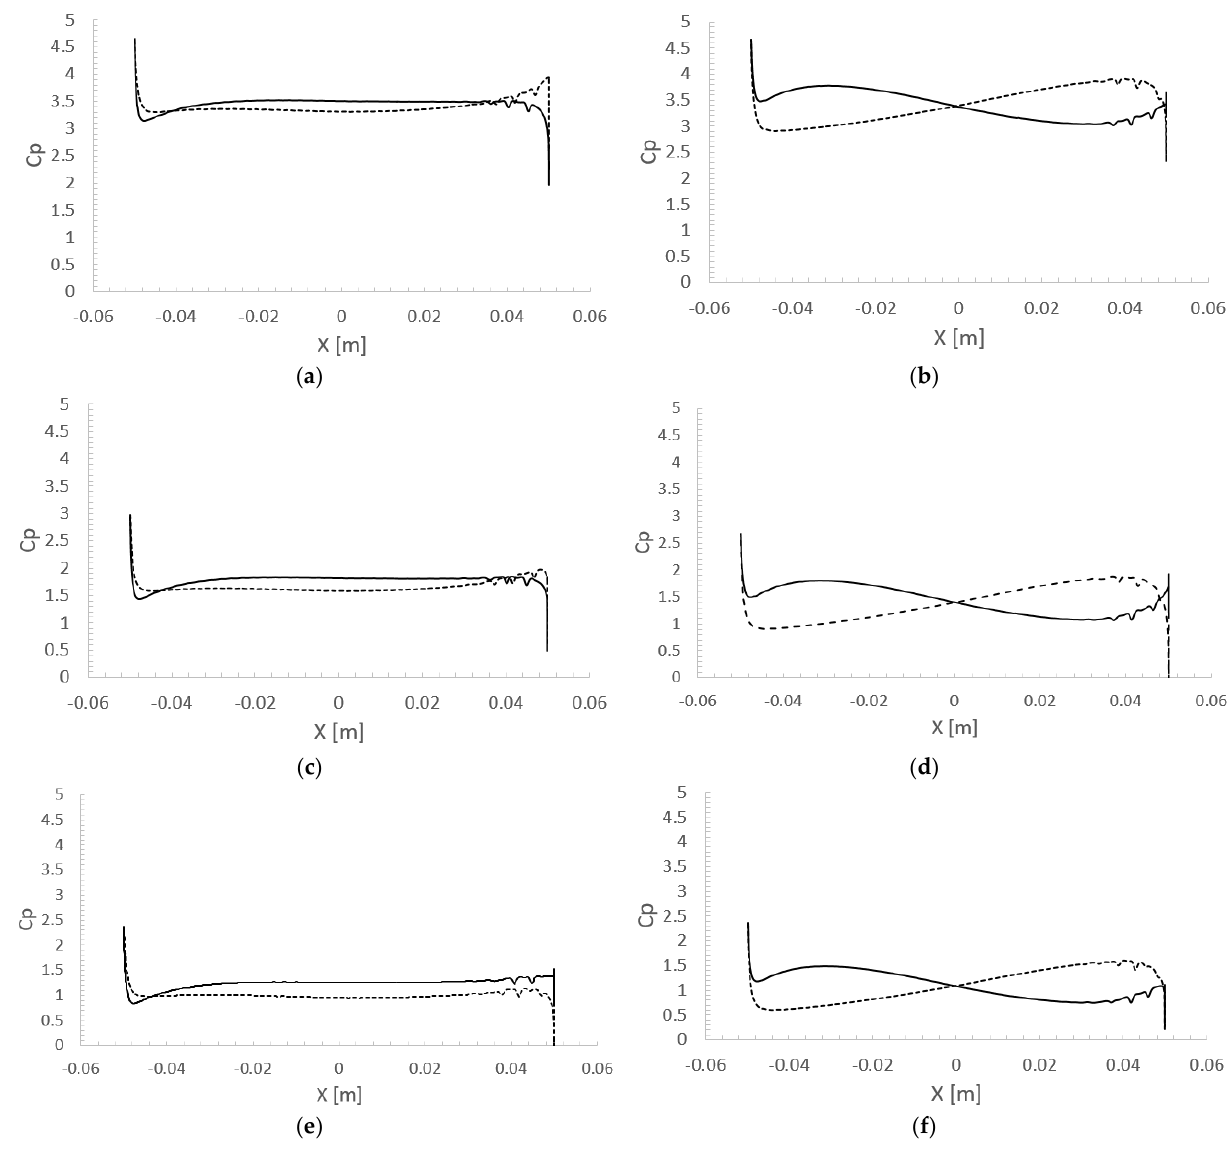
Figure 13. Cp coefficient over the NACA 0009 profile for σ ( a , c , e ) and t / T = 0.25 ( b , d , f